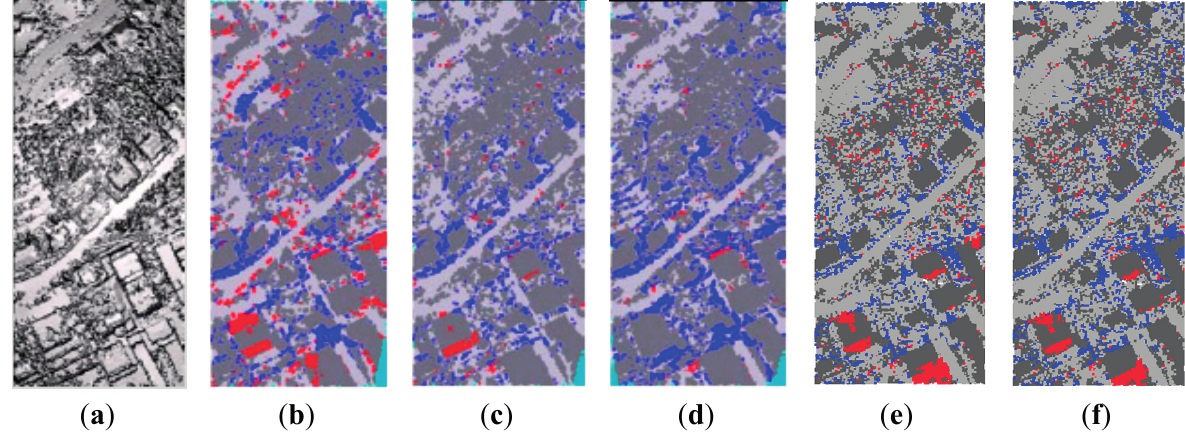
Figure 12. Comparison of the filtering results of different methods for sample 11: ( a ) DSM generated from the raw point clouds; ( b ) Sohn; ( c ) Axelsson; ( d ) Pfeifer; ( e ) Li et al. [38]; ( f ) This paper.